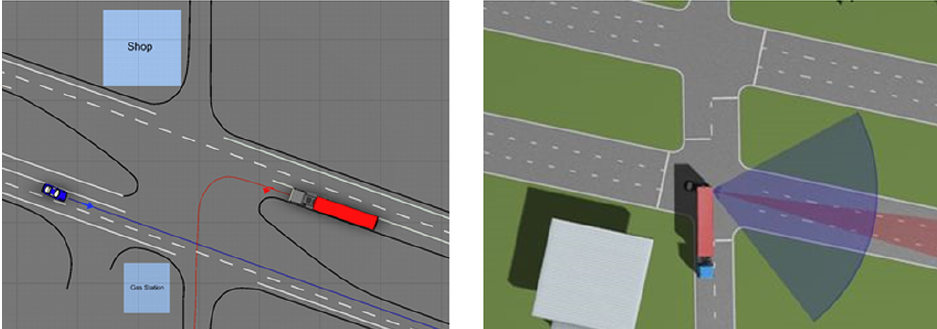
Figure 2. Top view about the first scenario when Tesla crashed into a truck; reconstruct with two